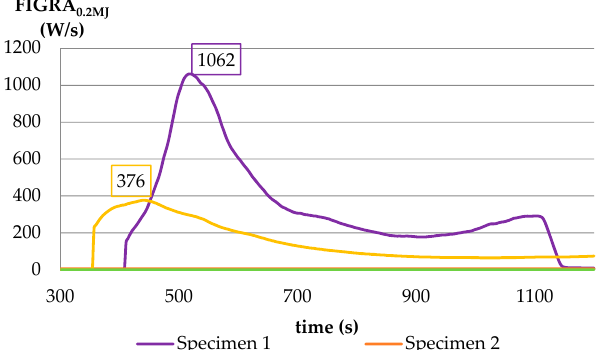
Figure 4. The comparison of the fire grown rate (FIGRA 0.2MJ ) results as a function of time at the SBI test.